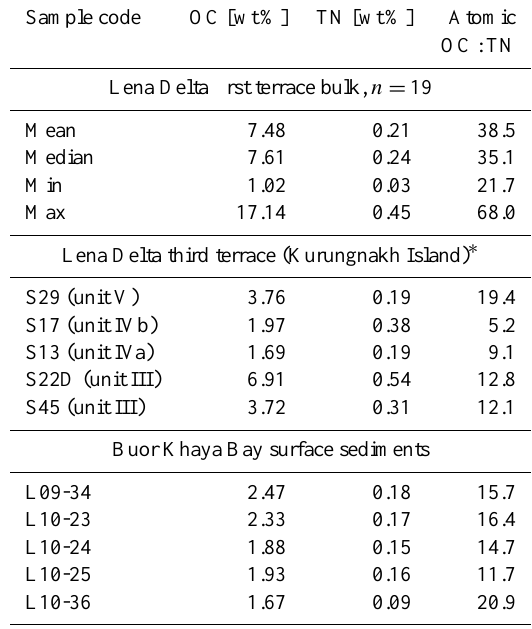
Table 3. Organic carbon (OC), total nitrogen (TN), and atomic OC:TN ratios of the Lena Delta soil samples (first and third ter- race) and Buor Khaya Bay surface